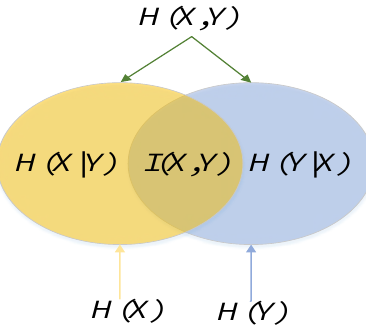
Figure 1. Event X and Y are connected by information entropy.